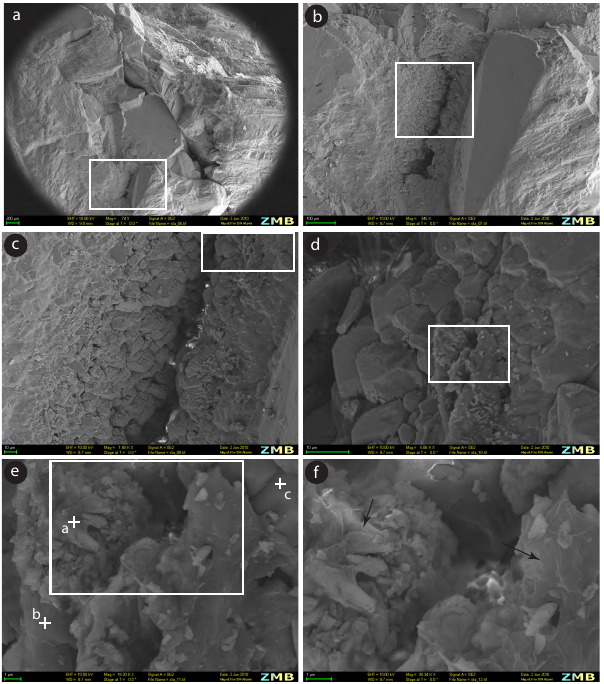
Figure 3, Pacton et al. Fig. 3. Secondary electron images of the surface of the stalactite: (a, c) the contacts between layers show the terminations of colum- nar crystals characterized by cavities and irregular crystals; (d, f) irregular small calcite crystals are covered by EPS-like structures showing sheet morphologies (arrows).